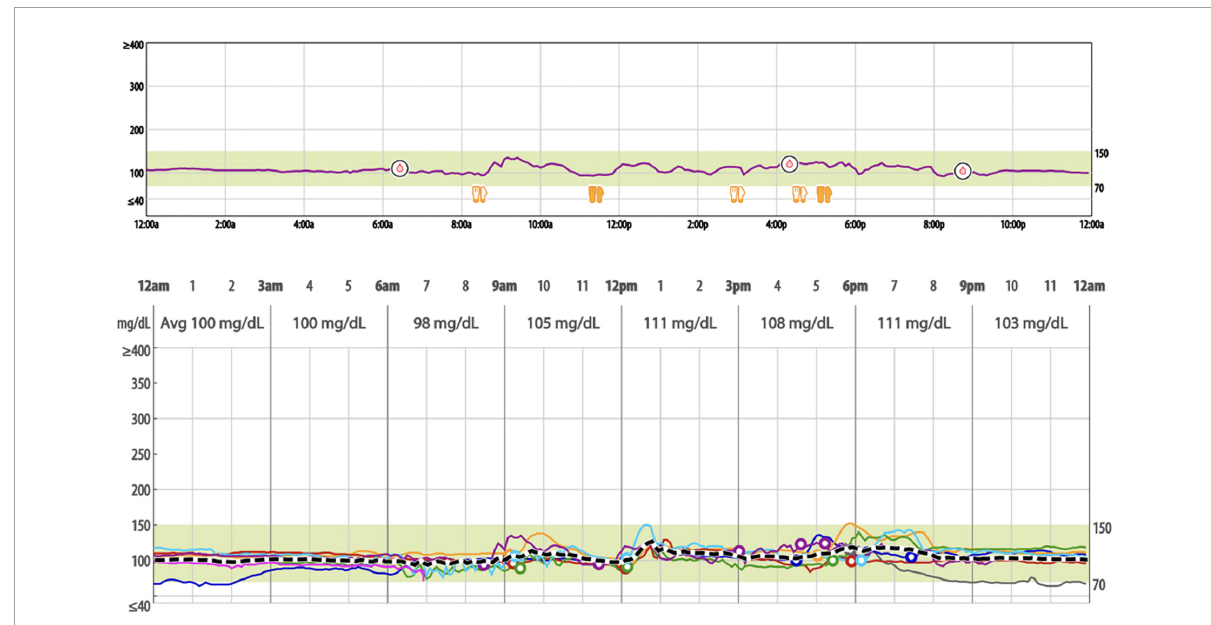
FIGURE1 Example of a 24-hour period of continuous glucose monitoring with iPro2 and overlayed weeklong sensor data (mg/dl).